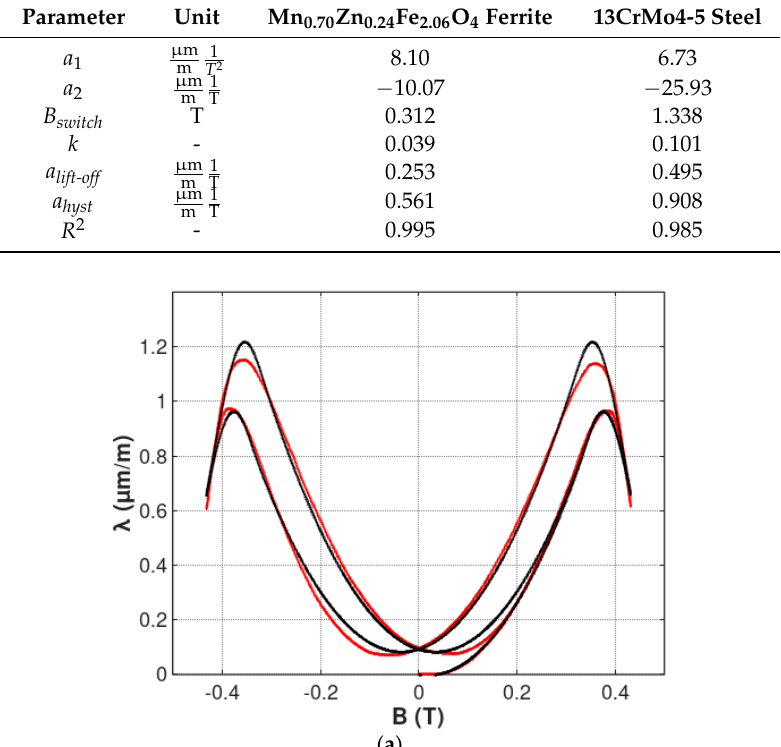
Table 1. Parameters of magnetostrictive λ ( B ) hysteresis loops determined in optimization process.